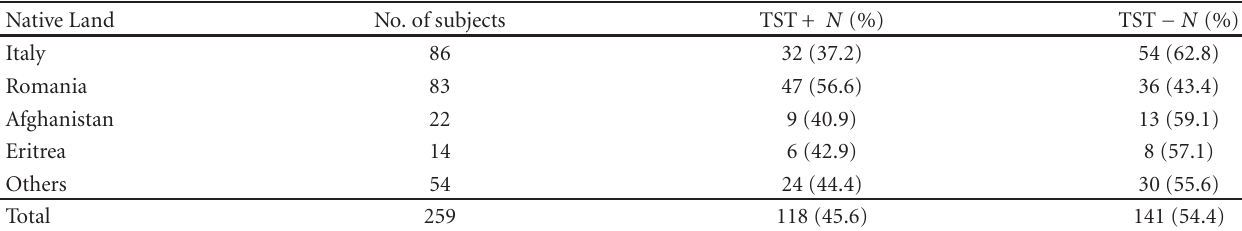
Table 2: Results of the TST by the native land.